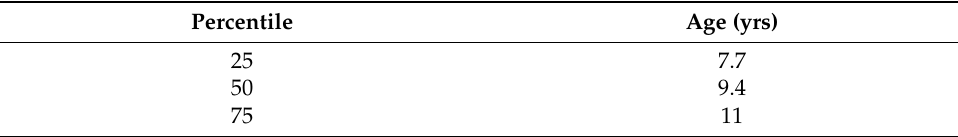
Table 1. Percentile according to age in our population.